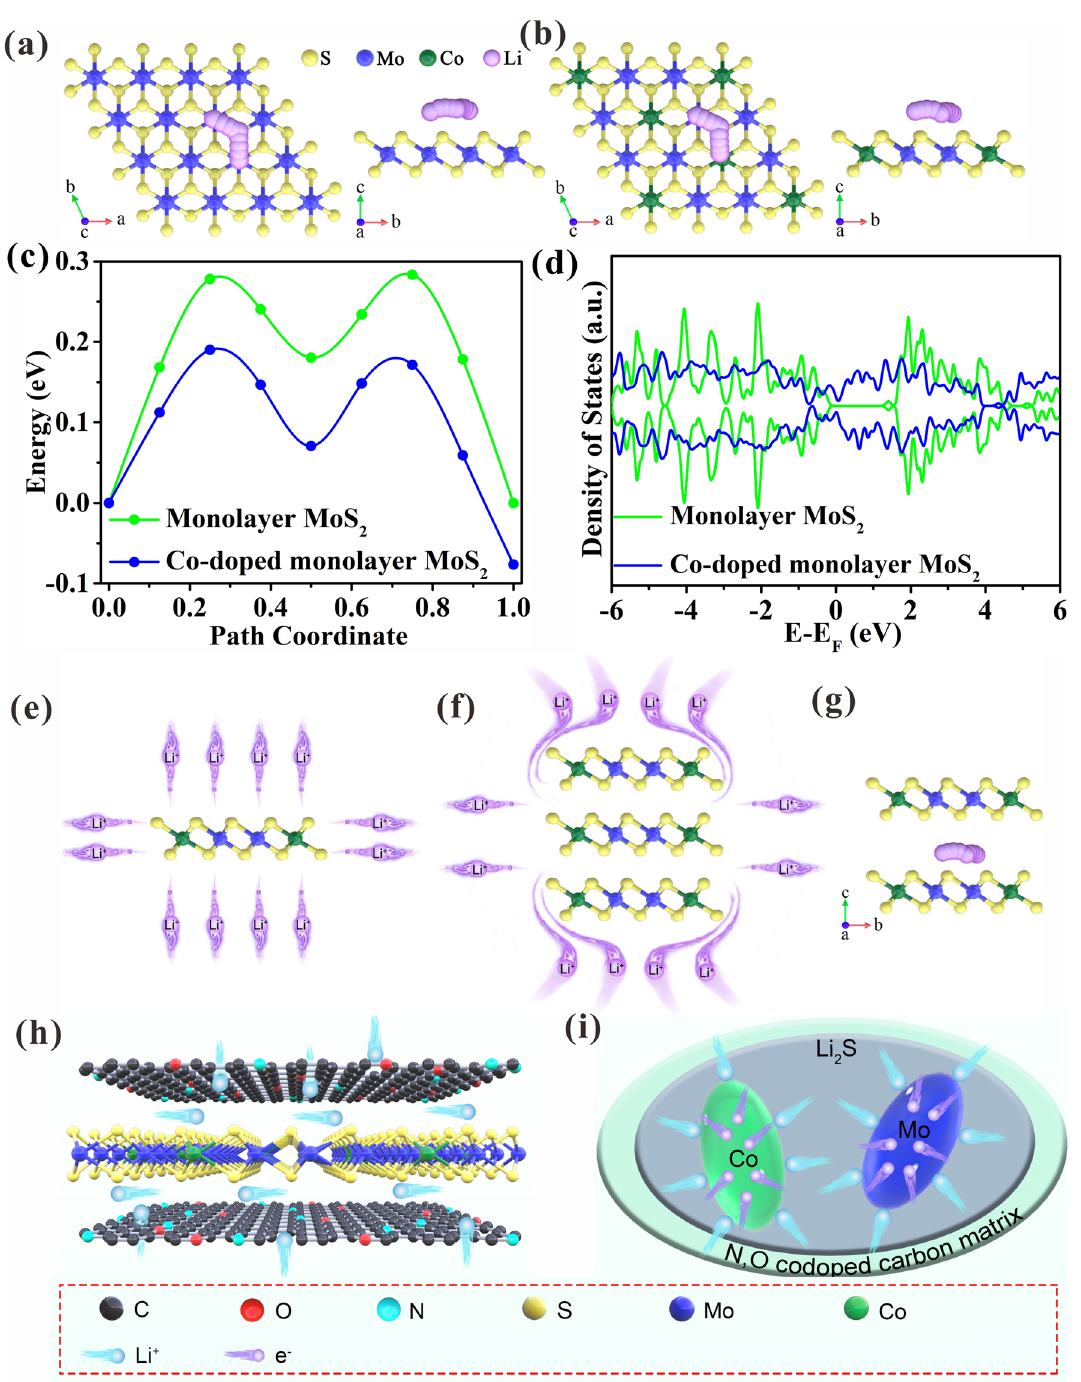
Fig. 7 Configurations of Li + migration paths in a monolayer MoS 2 , b Co-doped monolayer MoS 2 , c Li + diffusion energy barrier. d Calculated DOS. Schematic diagram of lithium ion e isotropic transport in monolayer MoS 2 , and f anisotropic transport in multilayered MoS 2 . g Configura- tions of Li + migration paths in multilayered MoS 2 . h , i Diagrammatic sketch of Li + storage mechanism in CoMoS 2